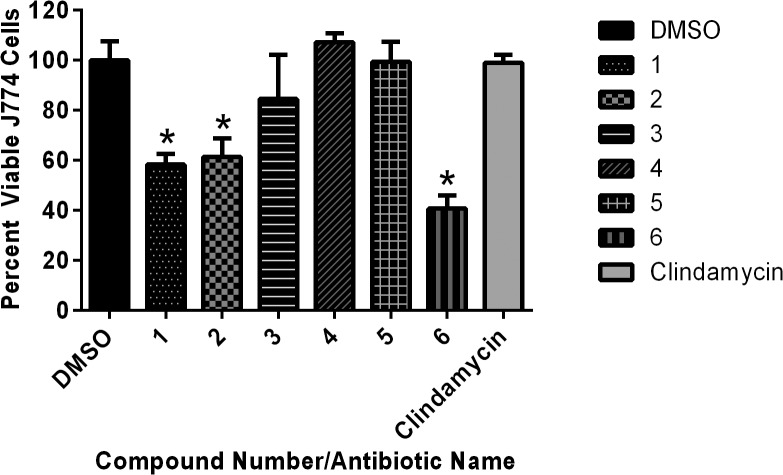
Toxicity analysis of thiazole compounds against murine macrophage (J774.A1) cells.The average absorbance ratio (test agent/DMSO) for cytotoxicity of thiazole compounds at 10 μg/mL against murine macrophage cells (J774.A1) was obtained using the MTS 3-(4,5-dimethylthiazol-2-yl)-5-(3-carboxymethoxyphenyl)-2-(4-sulfophenyl)-2H-tetrazolium) assay. DMSO was used as a negative control to determine a baseline measurement for the cytotoxic impact of each compound. The absorbance values represent an average of a minimum of three samples analyzed for each compound. Error bars represent standard deviation values for the corrected absorbance values. A one-way ANOVA, with post hoc Tukey's multiple comparisons test, determined statistical difference between the values obtained for compounds 1, 2, and 6 (denoted by the asterisks) relative to the cells treated with DMSO (P < 0.05).